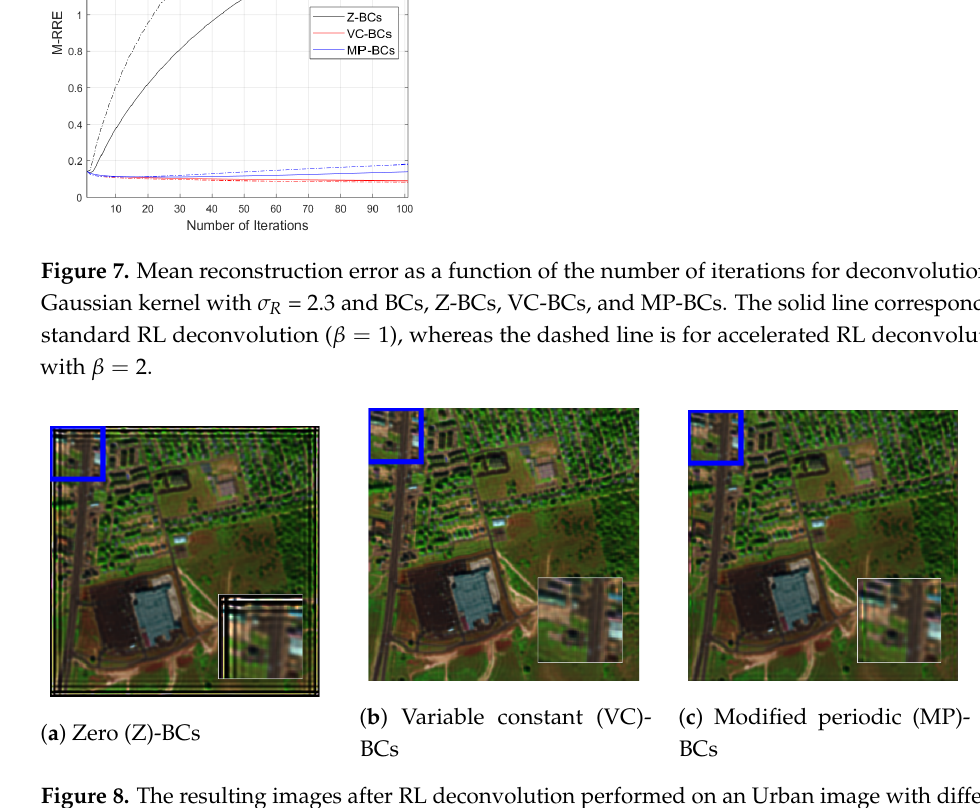
Figure 8. The resulting images after RL deconvolution performed on an Urban image with different